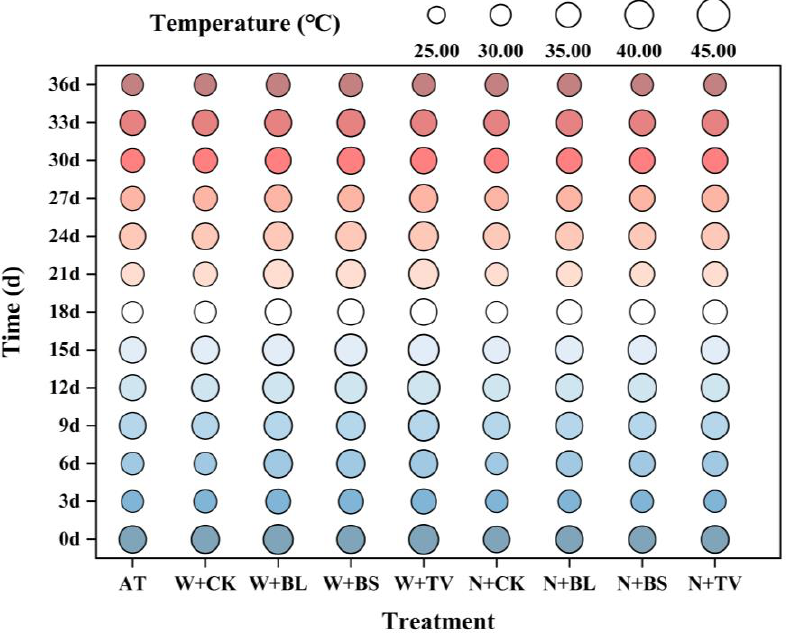
Figure 1. Changes in temperature values in the treatments. AT: Ambient temperature. Means ± SEs with different letters in each parameter indicate significant statistical differences ( p < 0.05).